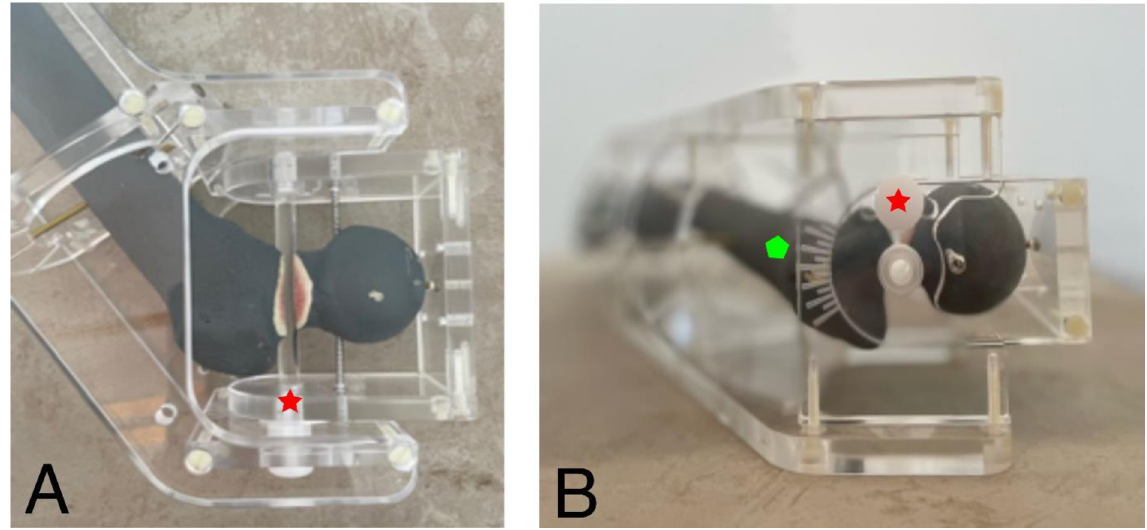
Fig 3. Overview of the goniometer device including the fixed Sawbone 1 model. A rotation axis of the fracture line (red star). B axial view of the device. The green pentagon marks the displacement scale. The red star depicts the rotational axis.